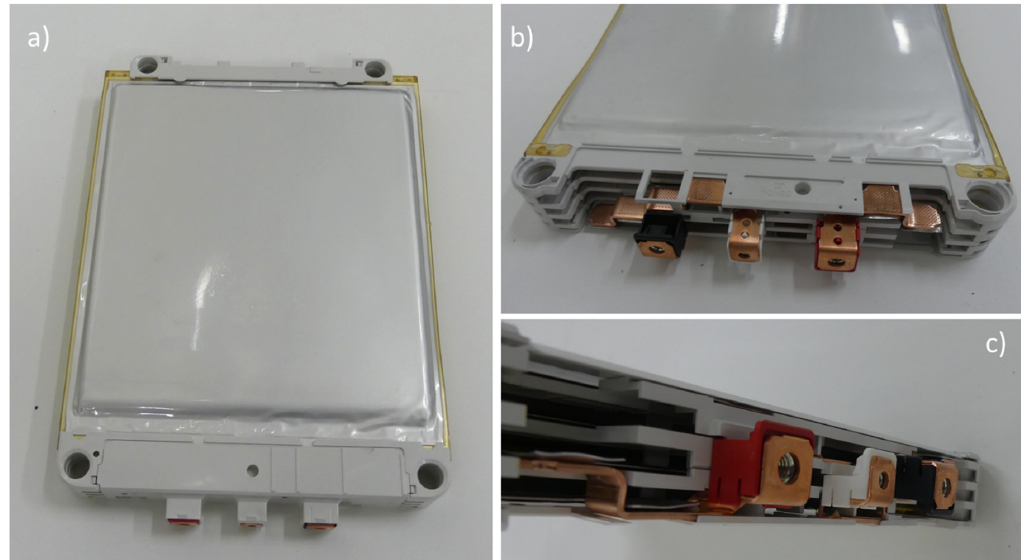
Figure 2. ( a ) Module sample used for test is composed of four cells stacked and glued to each other; each cell is surrounded by a plastic-silicon frame; ( b ) Top view of copper busbars: cells are electrically connected in the 2s2p configuration; ( c ) Detail of the connection busbars of module.